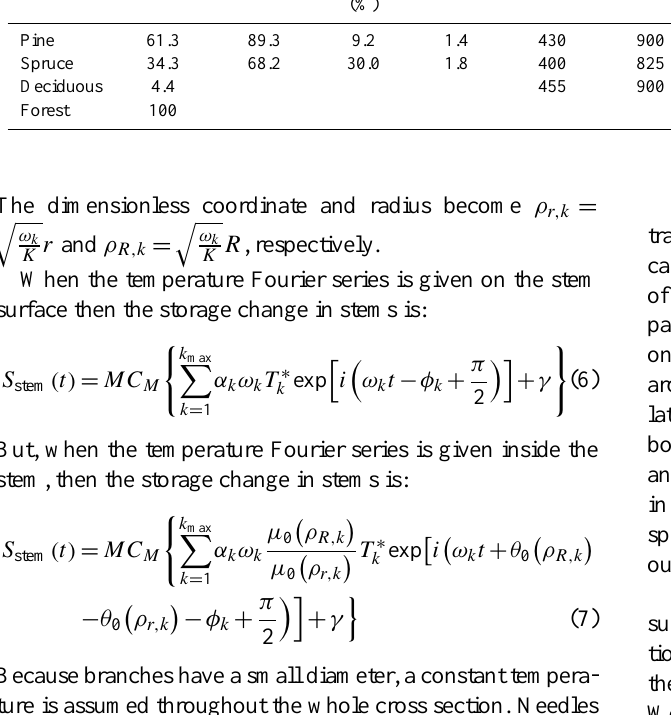
Table 2. Species and fraction distribution in the investigated stand. Species Fraction Stems (%) Needles